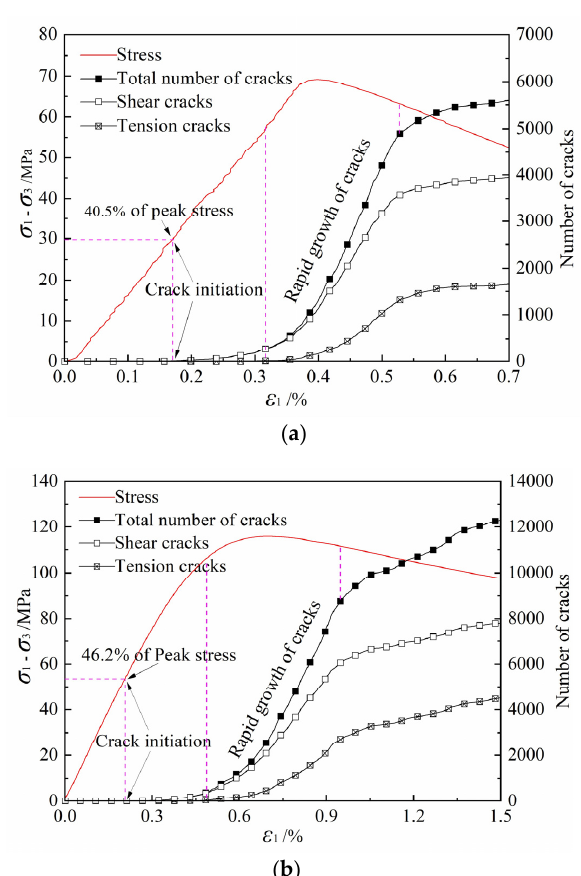
Figure 18. Correspondence between crack development and stress–strain curve under different confining pressures (RAC20). (a) 0MPa, (b) 10MPa